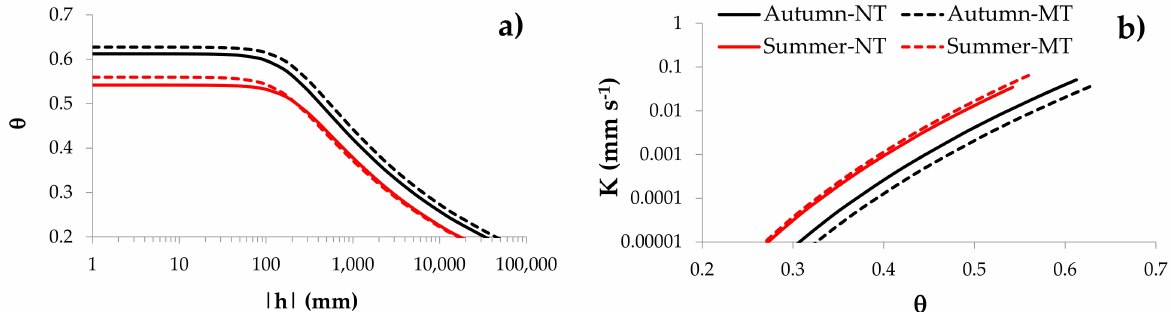
Figure 3. Water retention curves ( a ) and hydraulic conductivity functions ( b ) obtained with BEST- steady for minimum tillage (MT) and no-tillage (NT) in autumn and summer. WRCs and HCFs relating to the interaction between the sampling season and